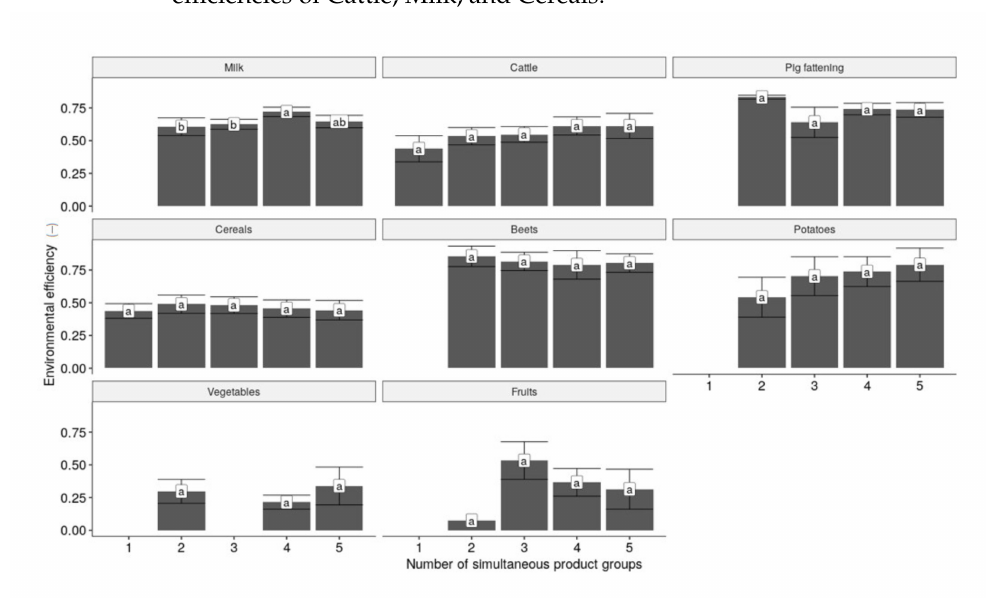
Figure 7. Comparison of the number of product groups and environmental efficiency. Shown are mean values (bar height) and standard errors. Mean values with different letters (a, b) differ significantly.